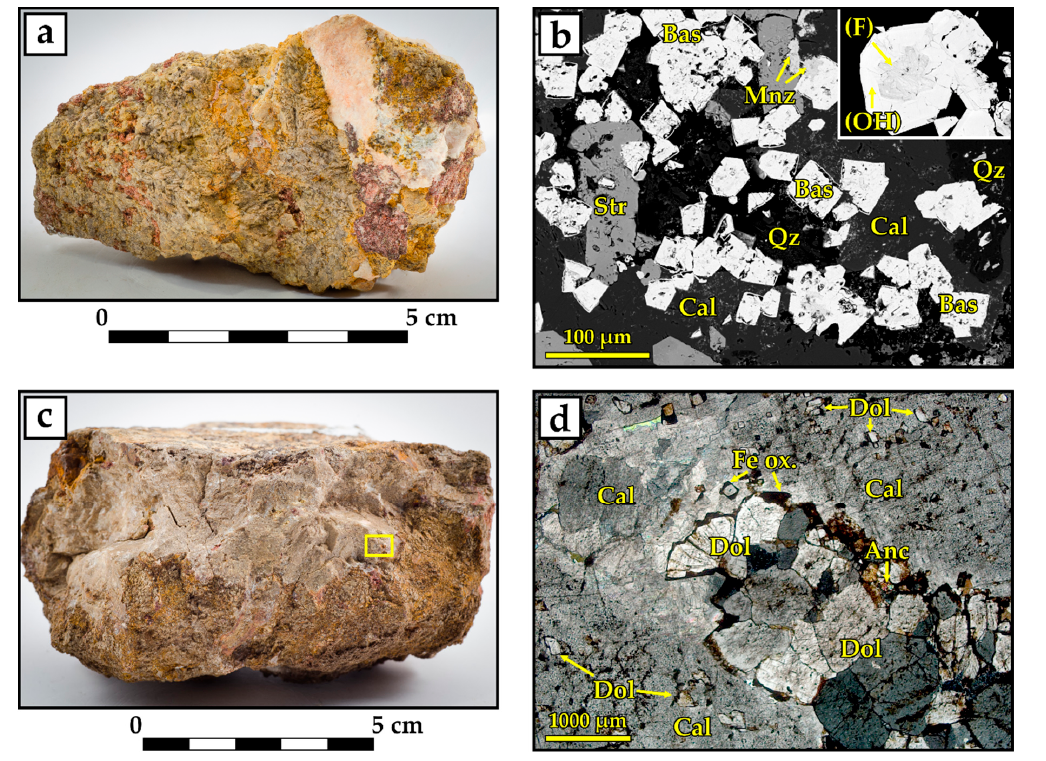
Figure 13. ( a ) Calcite–strontianite veinlets (pinkish-white), crossing the ancylite-bearing magnesiocarbonatite with pseudomorphs after burbankite (dark red segregations on the right side of the sample). ( b ) Polished section of the pseudomorph, composed of calcite, strontianite, baryte, monazite, quartz, and zoned bastnäsite; the inset shows a bastnäsite (F) core with a hydroxylbastnäsite (OH) rim. ( c ) A fragment of a gigantic-grained calcite vein from the margin of ancylite-bearing carbonatite. ( d ) Vein selvage (yellow rectangle in photo c ) with fragments of the enclosing magnesiocarbonatites and separate dolomite inclusions in the gigantic-grained calcite. Photomicrographs ( b ) under backscattered electrons (BSE images) and ( d ) transmitted cross-